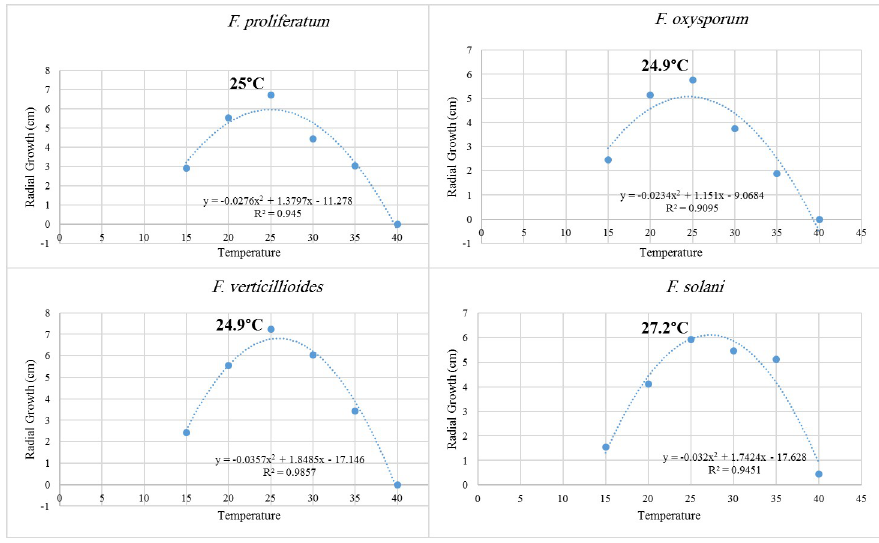
pathogenic Fusarium spp. Among DNA-based methods used to assess genetic variations of organisms, SSR loci become the markers of choice for studying genetic diversity of organisms. Many studies have also evaluated the transferability of SSR across species and genera of differ- ent kingdoms including fungi and plants [22]. In this study, SSR markers previously developed for F . verticillioides and F . oxysporum have been used to determine genetic diversity of Fusar- ium strains recovered from date palm trees in Saudi Arabia. The four SSR primer-pairs of F . oxysporum amplified fingerprints from Saudi Fusarium strains. However, eight out of the ten